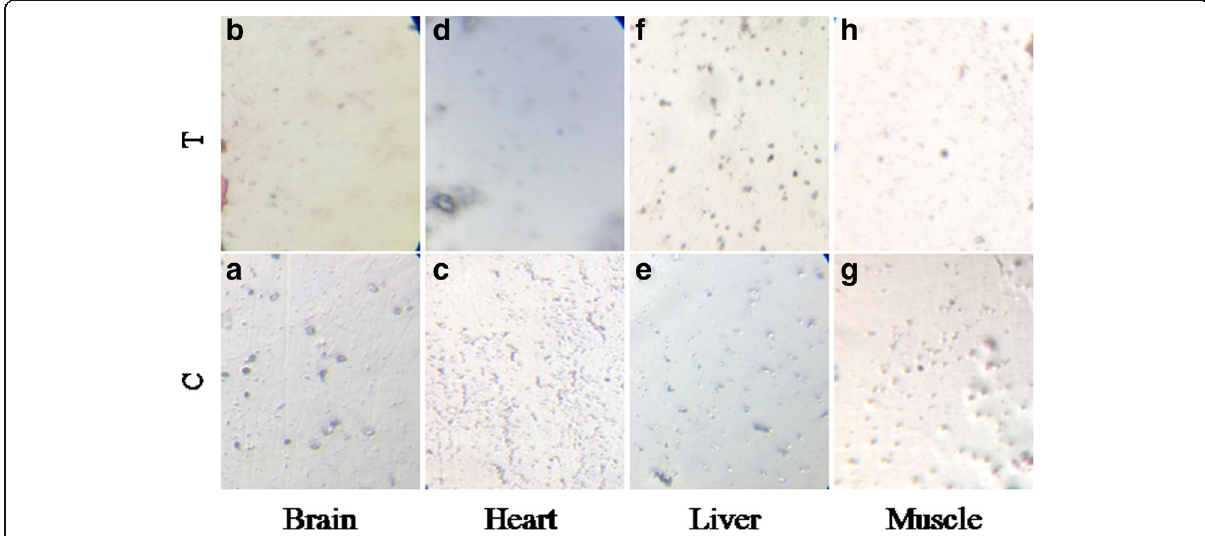
Fig. 7 Toxicology analysis in Tissue-Chip. The pathology studies of vital organs namely brain, heart, liver and muscle were analyzed in both control ( a , c , e , g ) and in treated ( b , d , f , h ) tissue chip. The treatment with algal extract 500 μ g did not affect the tissue architecture. The results of tissue chip analysis also support GAE to be safe without toxicity. These tissues were developed and analysed for toxicity in Tissue-Chip Pentagrit, Chennai. C-control, T-treated